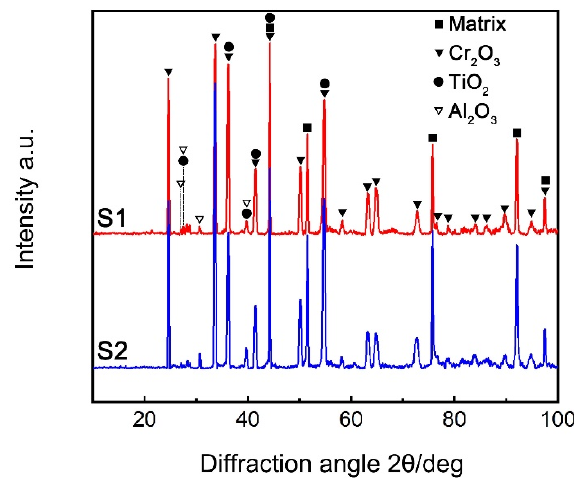
Figure 5. XRD patterns of S1 and S2 oxidized in air at 1000 °C for 200 h.